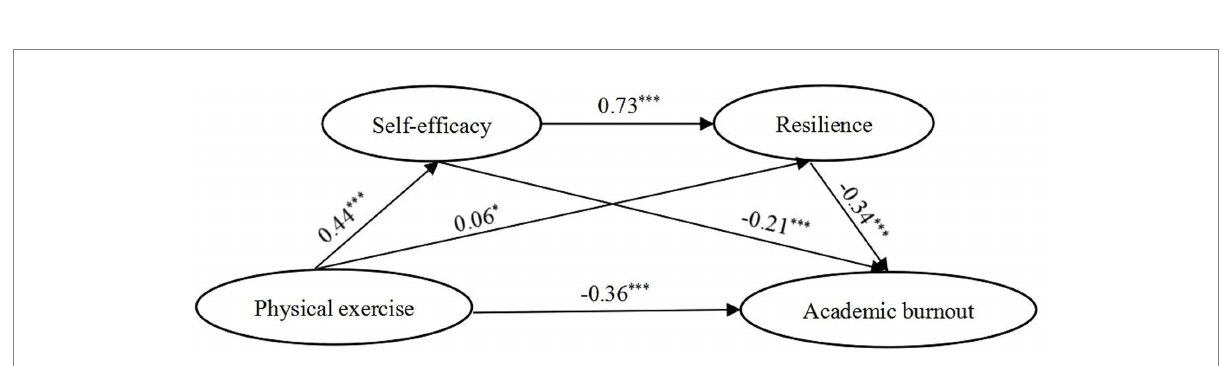
FIGURE 2 Model showing the mediating roles of self-efficacy and resilience in the relationship between physical exercise and academic burnout (Female sample). *** p < 0.001, * p < 0.05; significant standardized regression